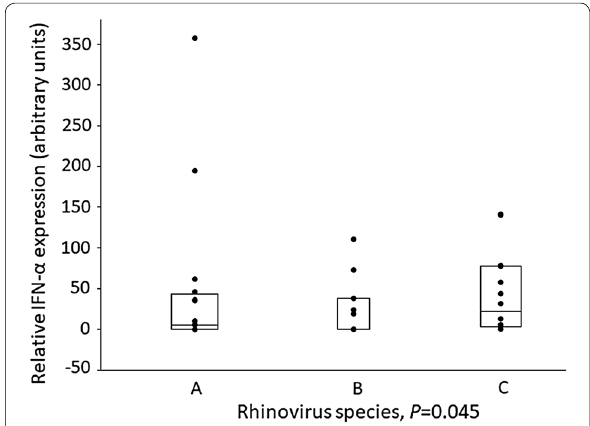
Fig. 2 Relative tonsillar expression of IFN-α. Comparison of tonsil samples between 16 RV-A, 12 RV-B and 14 RV-C positive patients (Table 3). Values are arbitrary units 10 4 relative to EF1α. Data × represents median with interquartile range. The median of RV-B is 0.37. IFN, interferon